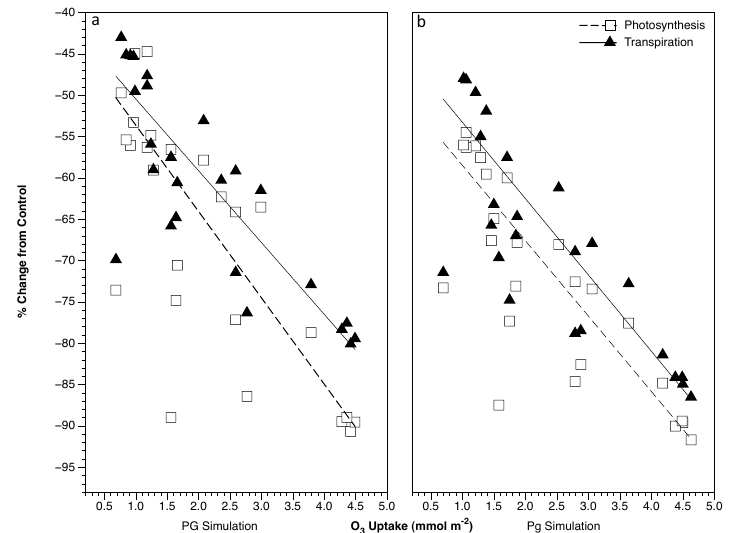
Fig. 3. Percent change from control CLM simulations in photosynthesis and transpiration over a range of O 3 uptake in the PG (direct change to conductance; (a) and Pg (indirect change to conductance; (b) simulations. Results are from a 5 × 5 gridded region centered on Ithaca, NY (latitudes between 270–280 ◦ ; longitudes between 38–46 ◦ ) as modeled by the CLM. Points are gridcell averages from August of the 10th simulated